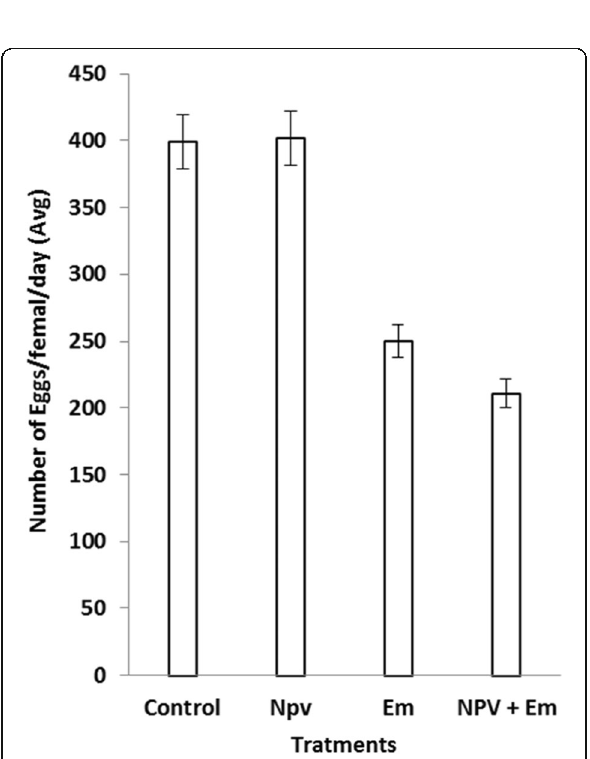
Fig. 6 Median lethal inactivation time (LIT 50 ) of Spodoptera littoralis 2nd instar larvae treated with Spli MNPV, Em, and Em Lc 50 + Spli MNPV Lc 99 all exposed to different natural sunlight periods